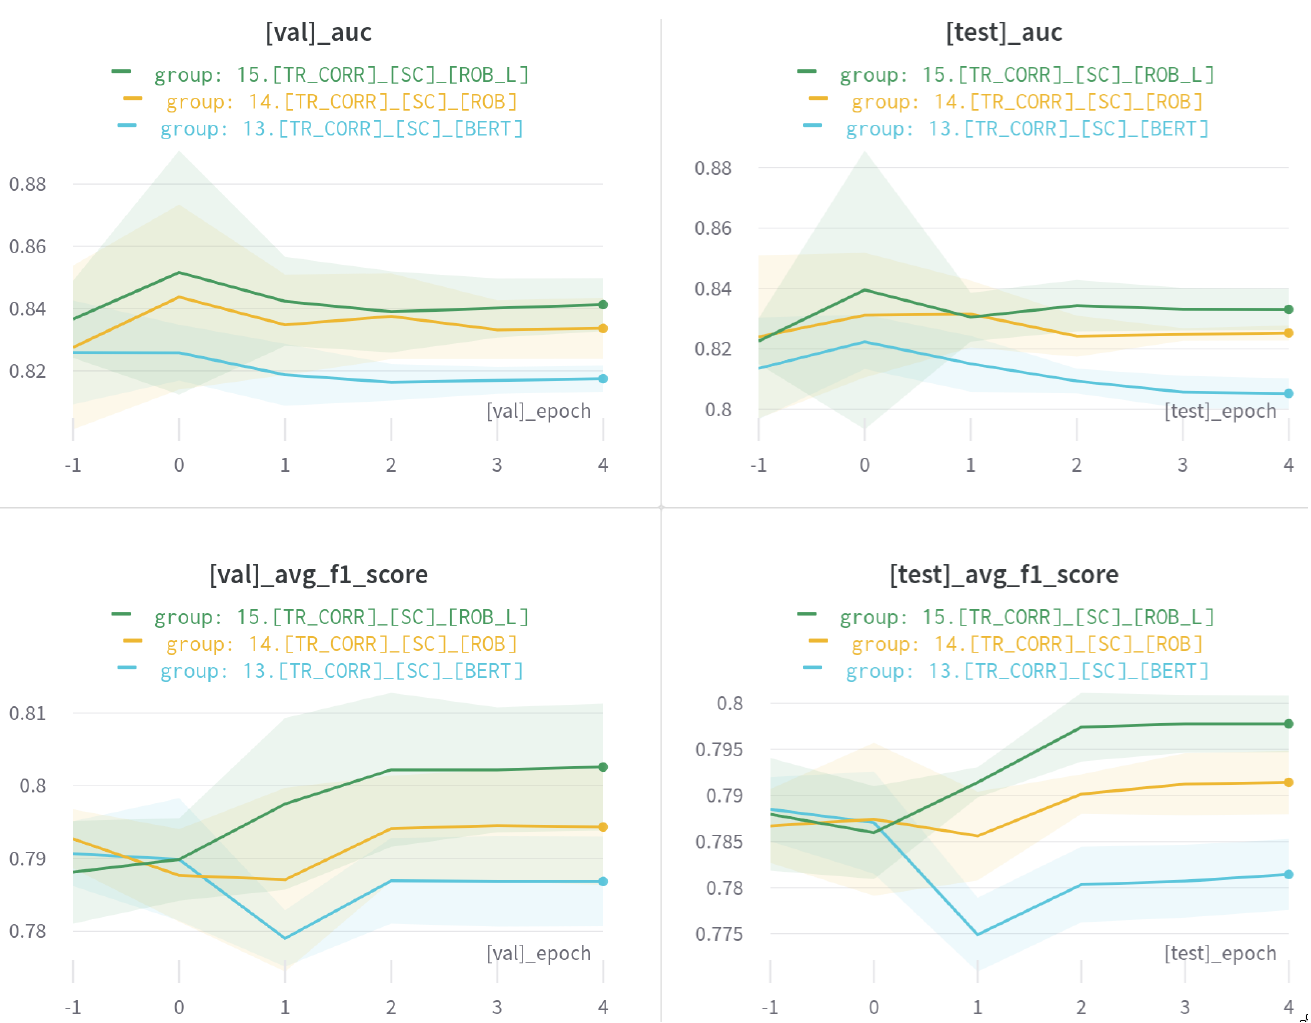
Figure 13. Index extraction results (AUC and F1 score) of three different models (i.e., Bert, RoBERTa-base, and RoBERTa- large). Shaded area is the standard deviation of 5 models from cross-validation, and solid lines denote average metrics displayed top of each